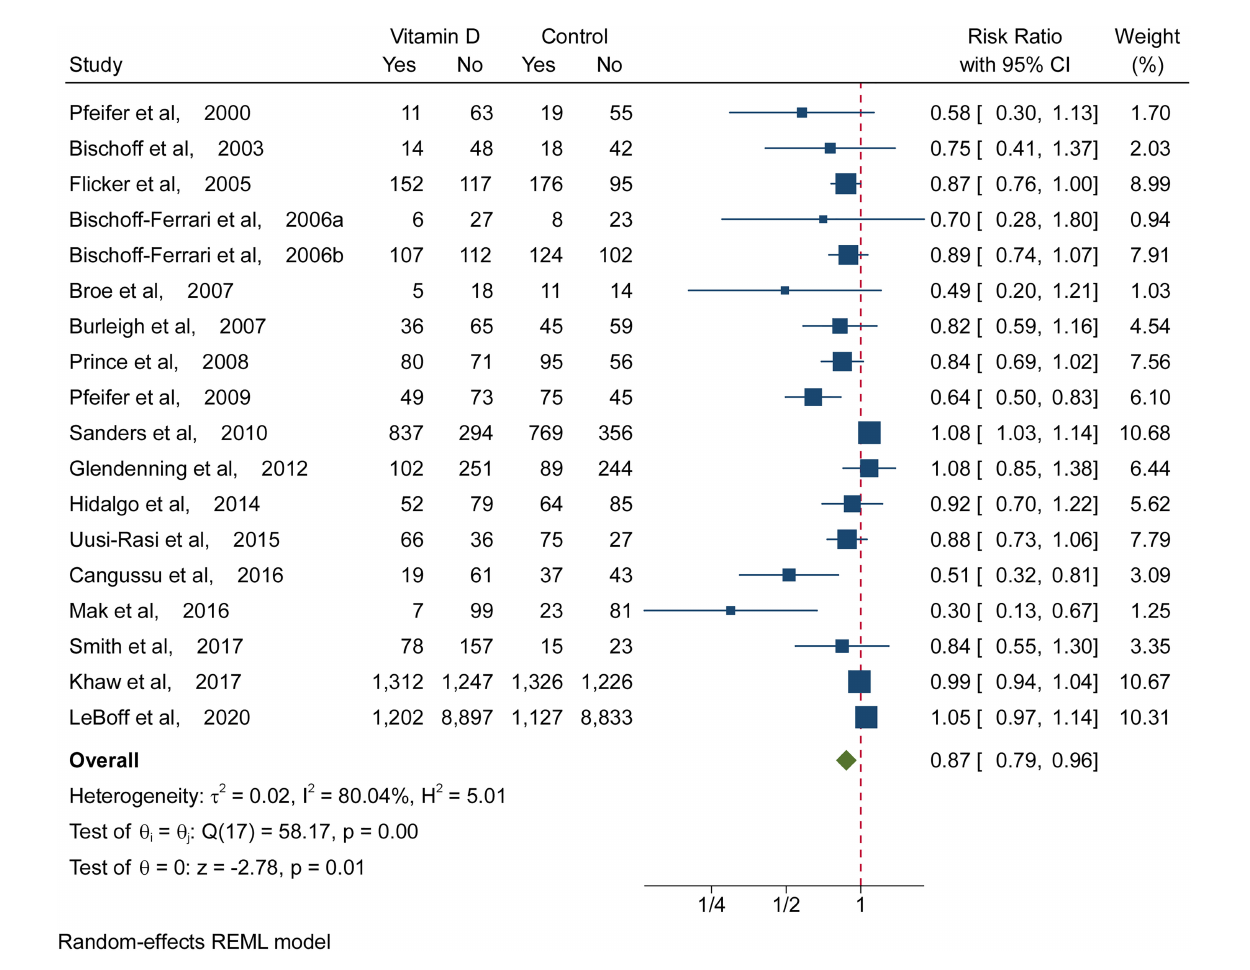
FIGURE 2 | Meta-analysis Results of Vitamin D Supplementation for the Incidence of Fall. Risk ratios and 95% CIs were calculated using a random-effects model to pool data. Boxes represent relative risks, and the size of the boxes is proportional to the size of the high dose supplemental vitamin D trials included in the primary analysis. Error bars represent 95% con fi dence